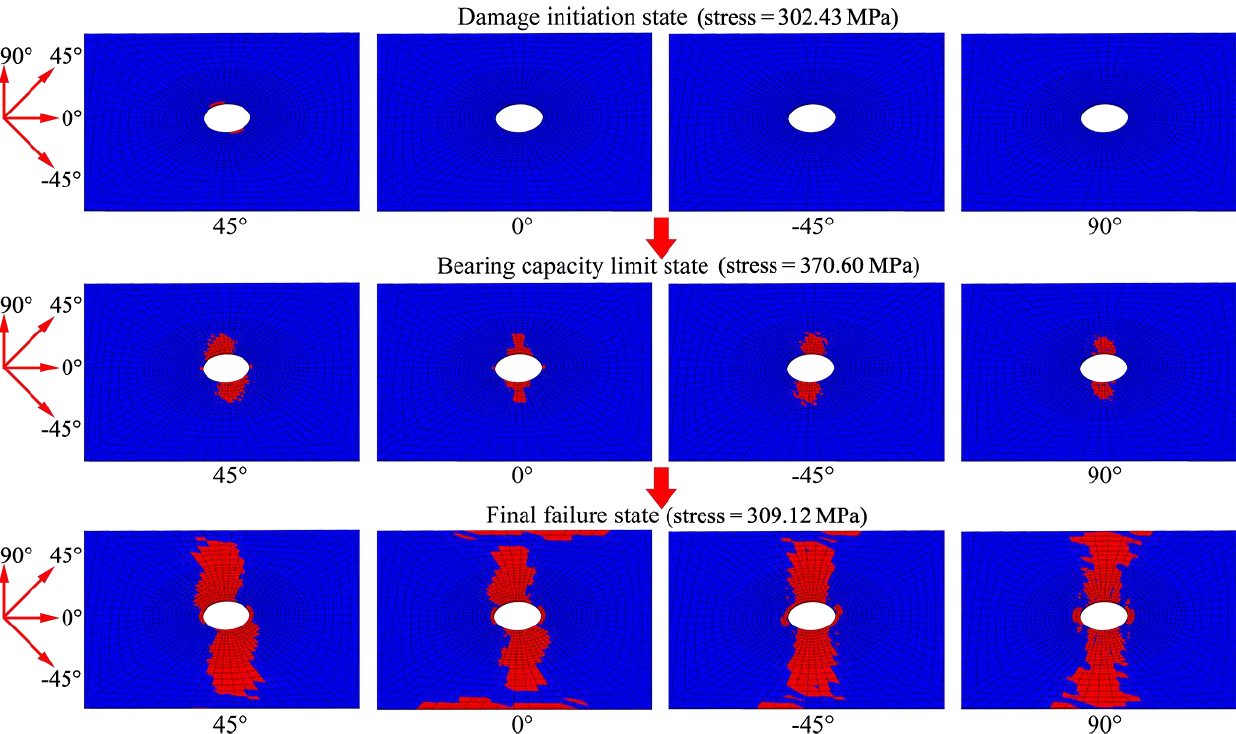
Figure 10. Illustration of delamination damage evolution at four plies of the second sub-laminate in different loading